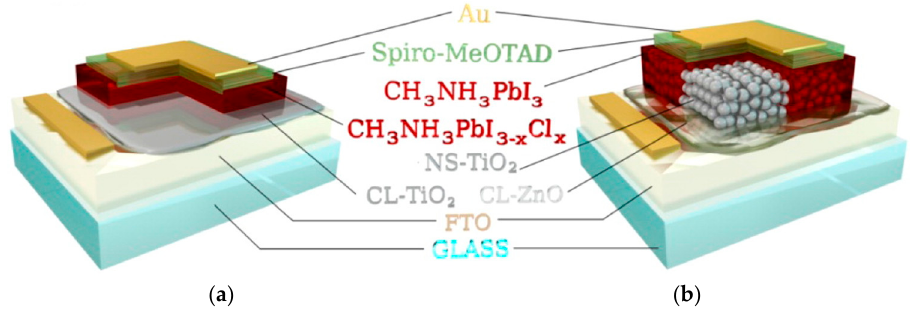
Figure 14. ( a ) Planar structure without a mesoporous layer; and ( b ) mesoscopic PSCs with mesoporous TiO 2 layer. Reprinted with permission from [65]. Copyright 2014 American Chemical